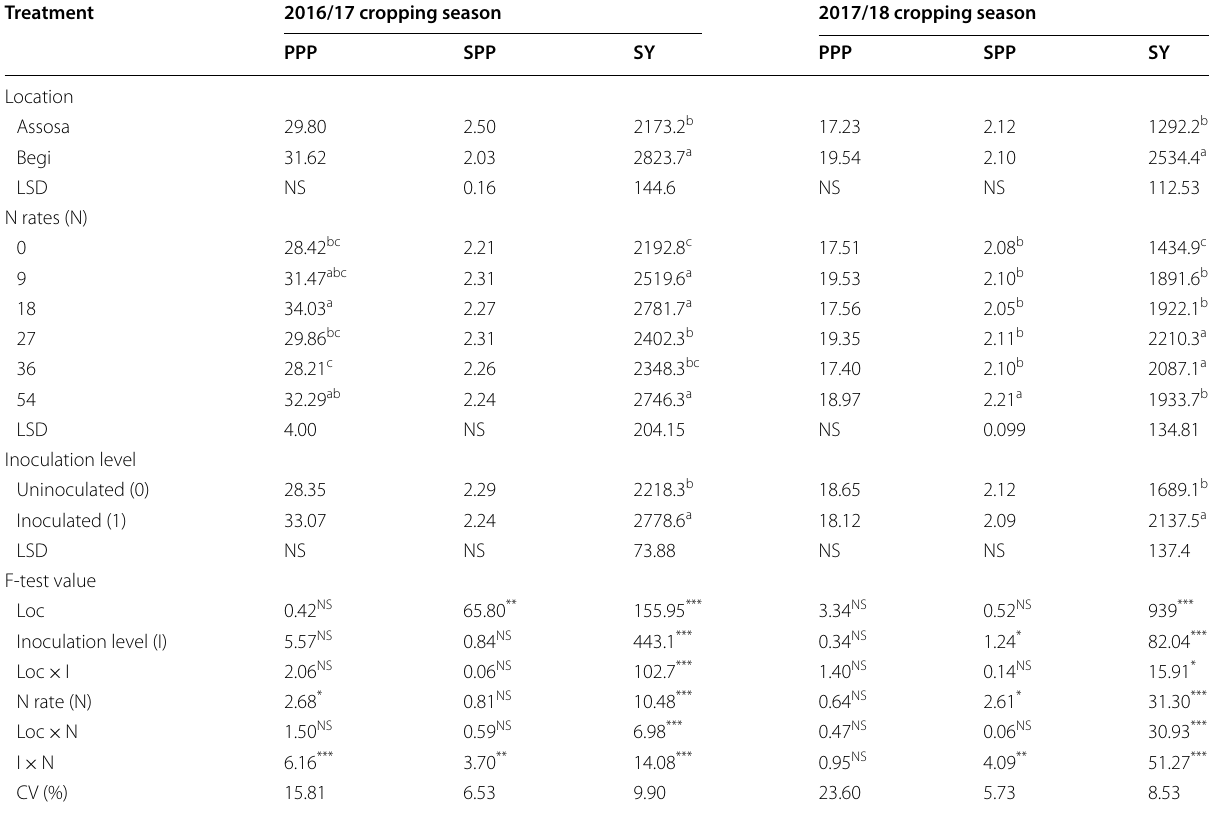
Table 4 Effect of N rates and Rhizobial inoculation on yield components and seed yield of soybean for 2016/17 and 2017/18 cropping